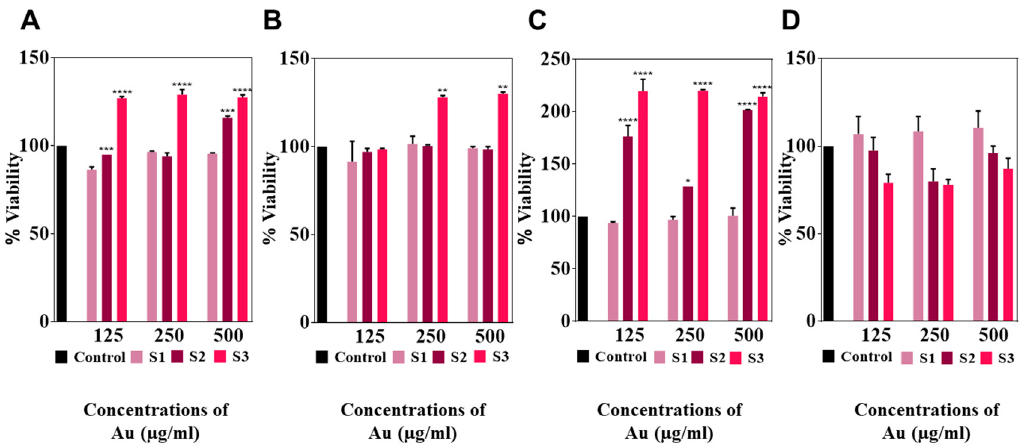
Figure 4. Determination of AuNPs generated cytotoxicity towards primary human dermal fibroblasts (HDFs). Cells were treated with different concentrations of AuNPs for 24 and 72 h. Cell viability of 50% confluent HDFs after 24 ( A ) and 72 h ( B ) exposure; and 80% confluent cells after 24 ( C ) and 72 h ( D ). The untreated cells served as controls. The results are represented as ±standard error mean (SEM) ( n = 3). * p < 0.05, ** p < 0.01, *** p < 0.001, **** p < 0.0001. Asterisks indicate statistical significance compared to the control.